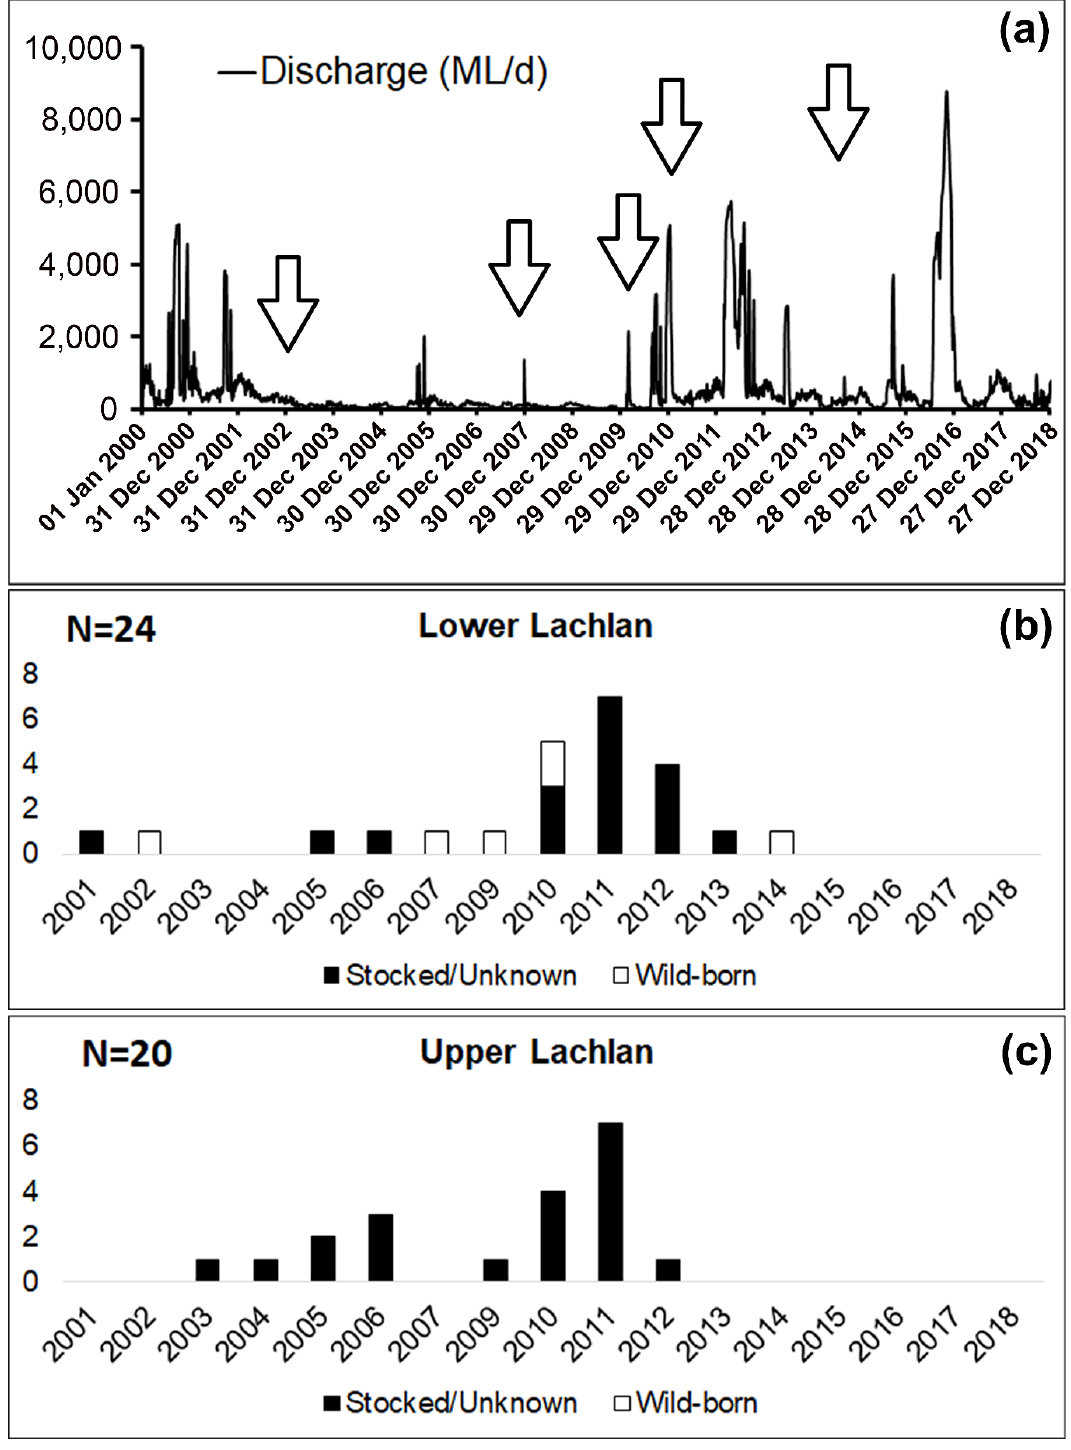
Figure 4. Daily discharge from the lower Lachlan since 2000 (Source: WaterNSW, https: // realtimedata.waternsw.com.au / ), and the number of stocked / unknown and wild-born fish from the Lachlan River and their spawning year. ( a ) Daily discharge (ML / day) at Hillston Weir (lat: − 33.4873 lon:145.504) from 1 January 2000 to 31 December 2018; ( b ) Samples from the lower Lachlan (N = 24); ( c ) Samples from the upper Lachlan (N = 20). White bars represent the number of wild-born fish, and the black bars represent the number of fish either stocked or from unknown